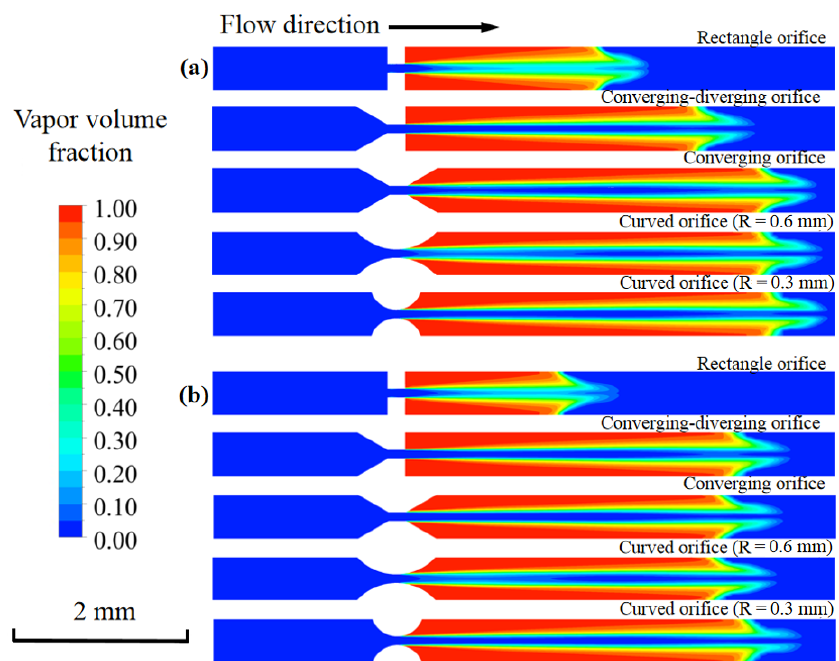
Figure 10. The vapor volume fraction with various orifice structures: ( a ) DI water and ( b ) nano-fluid.